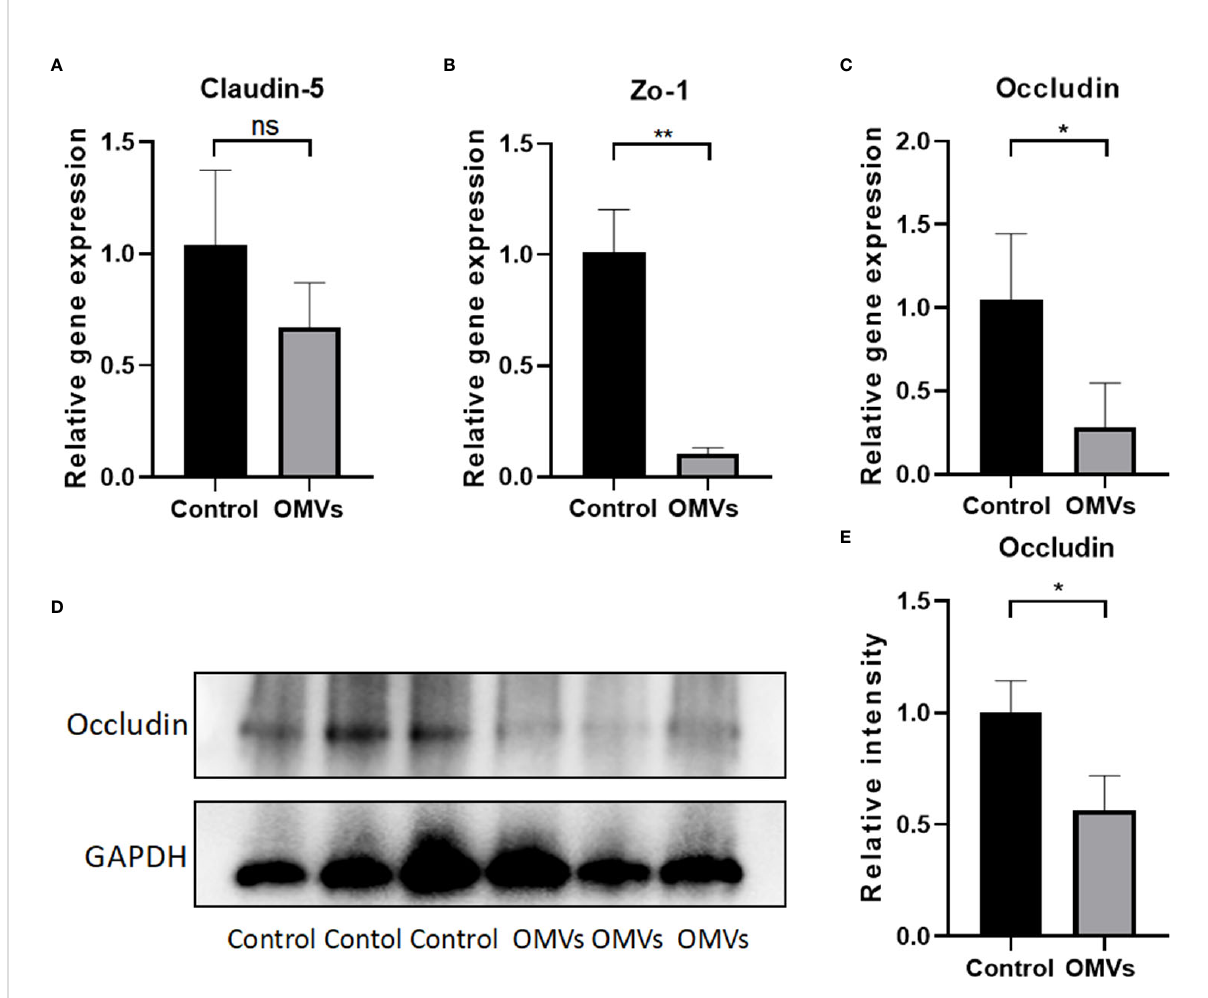
FIGURE 4 Oral gavage of Pg OMVs decreases tight junction – related gene and protein expression in the brain. (A – C) Gene expression of claudin-5, occluding, and zo-1 in the brain. (D) Occludin protein expression was measured by Western blot analysis. (E) The quantitative analysis of occludin immunoblots in (D). Values are expressed as the mean ± SEM. OMVs, outer membrane vesicle; SEM, standard error of the mean. ( n = 3, ns: P >.05, * p <.05, ** p